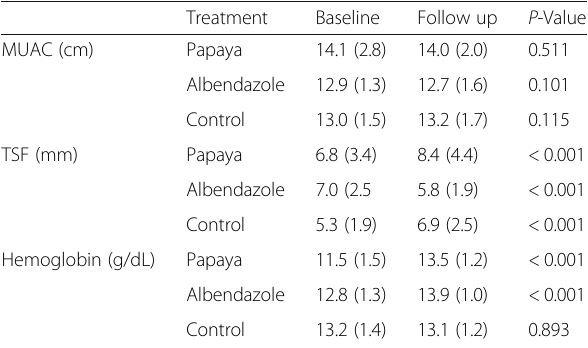
Table 4 Anthropometric outcomes and Haemoglobin levels of the children before and after 8 weeks intervention Treatment Baseline Follow